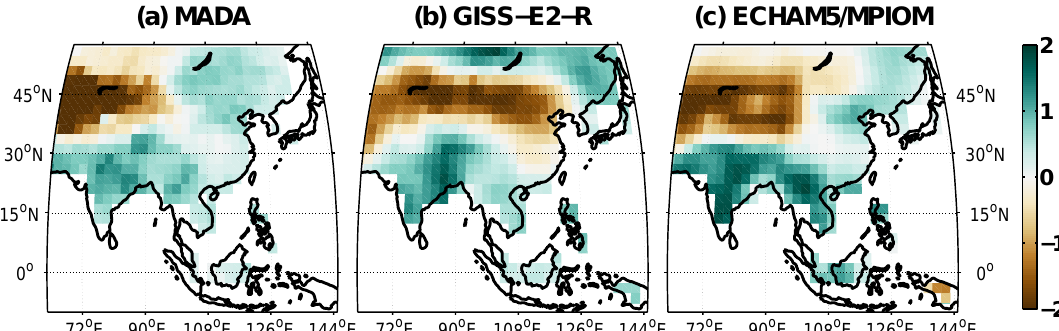
Figure 1. Asian monsoon failure patterns: (a) first EOF of PDSI for MADA and (b) for the ensemble mean of GISS-E2-R and (c) ECHAM5/MPIOM. Pattern correlation coefficients between (a) and (b) and between (a) and (c) are 0.57 and 0.78, respectively.